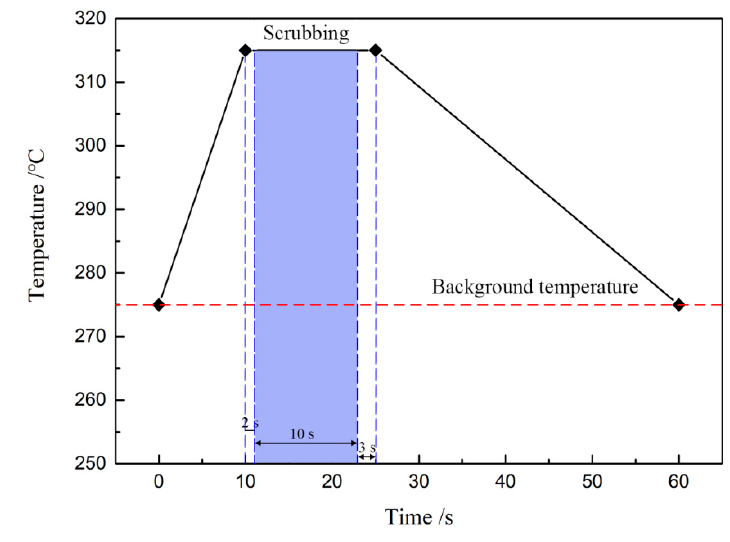
Figure 2. Technological process of Au-Sn eutectic bonding.